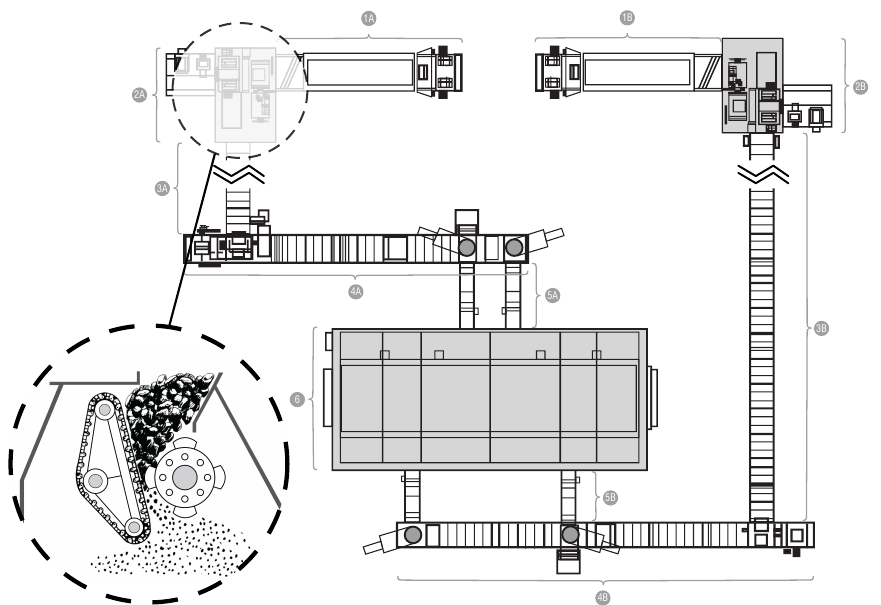
Figure 3. Diagram of the monitored object, which includes: Crushers (2A and 2B), feeders (1, 3, 4, and 5 (both A and B in each case)), and a boiler (6).